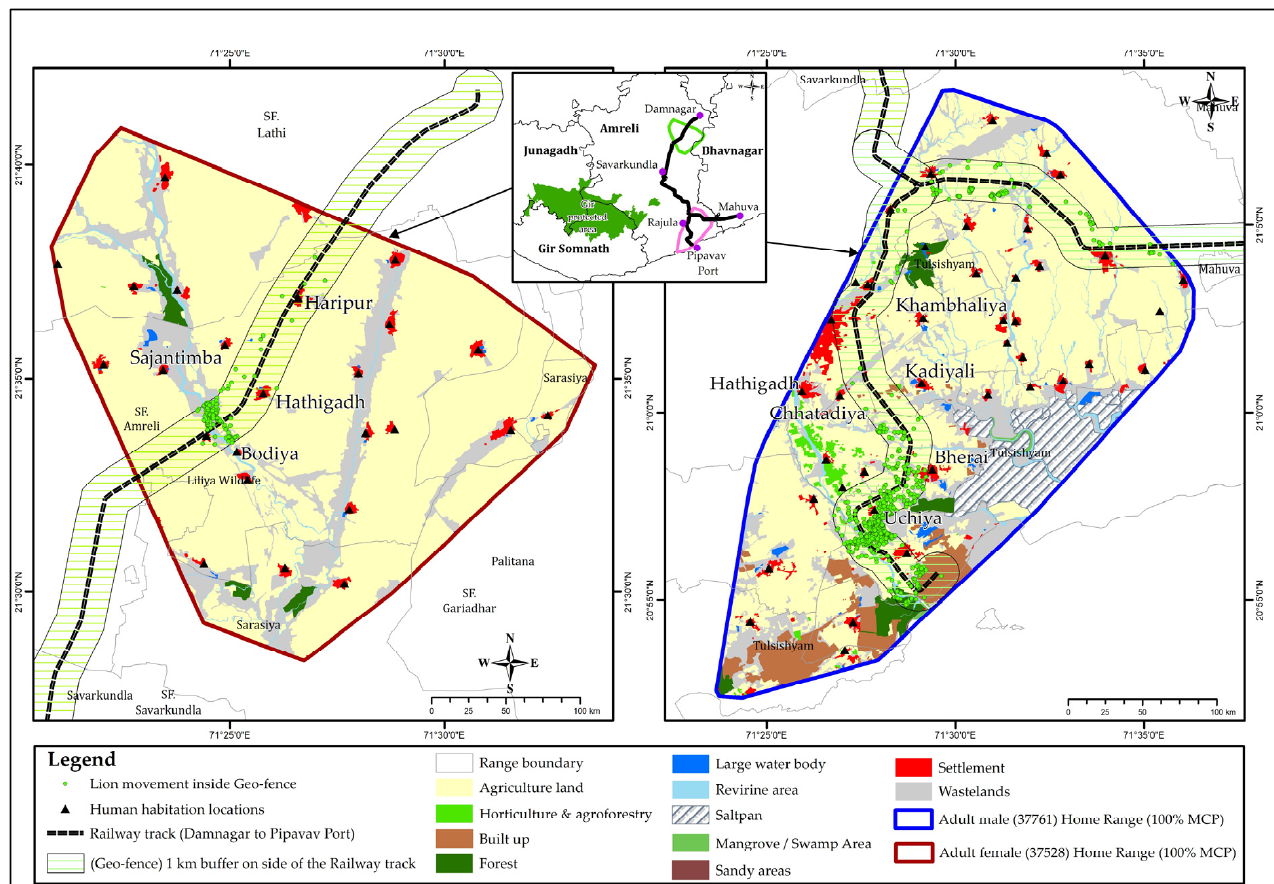
Figure 2. The home range of Asiatic lions, exclusively ranging in multi-use landscapes outside Gir Protected Areas (PAs), is vulnerable to linear infrastructures-related accidents such as roads and railway tracks. The safety of adult males (37761) and adult females (37528) was monitored through radio-telemetries’ virtual geofencing function.